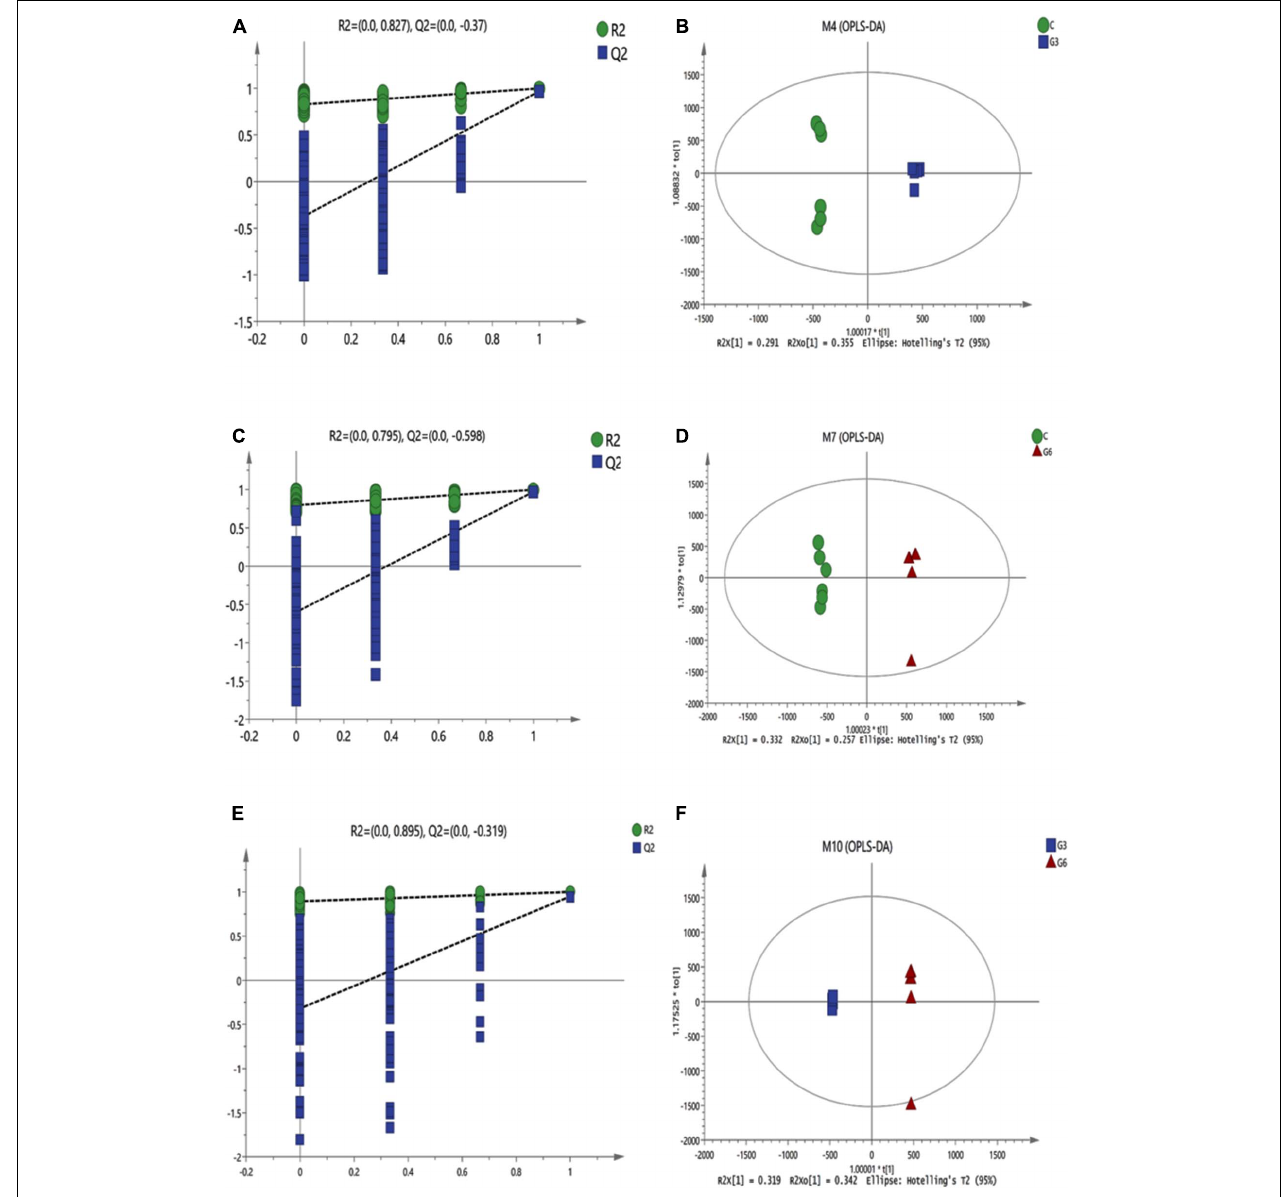
FIGURE 3 | The permutation test ( n = 200) of the OPLS-DA model (A,C,E) and OPLS-DA model (B,D,F) were derived from the liquid chromatography/mass spectrometry metabolomics profiles of yak rumen fluid samples from grass-fed (C), grain-fed for 3 months (G3), and grain-fed for 6 months (G6) groups. Green and blue respectively represent R2 value and Q2 value from the permutation test (A,C,E) . The green circles represent the C group, blue squares represent the G3 group, and the red triangles represent the G6 group (B,D,F) .